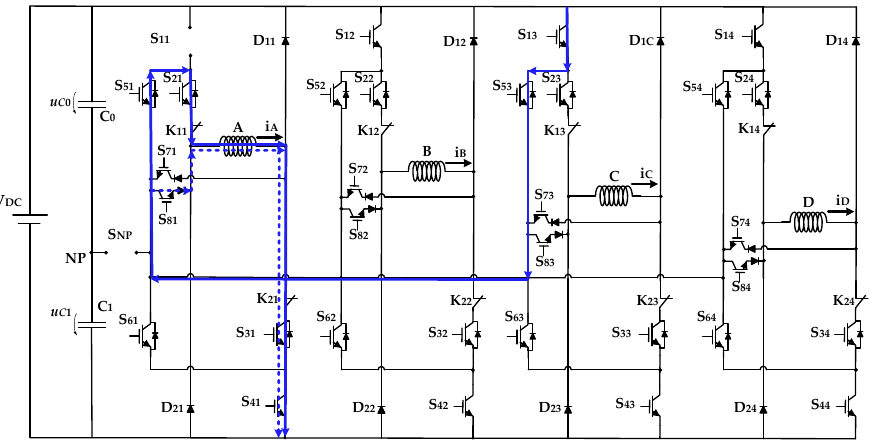
Figure 4. Fault-tolerant solution based on the NPC-AHB topology applied to an 8/6 SRM . Example of an open-circuit fault in power device S 11 and recover paths to obtain the full voltage of phase A . Two possible paths are available to achieve the full voltage.